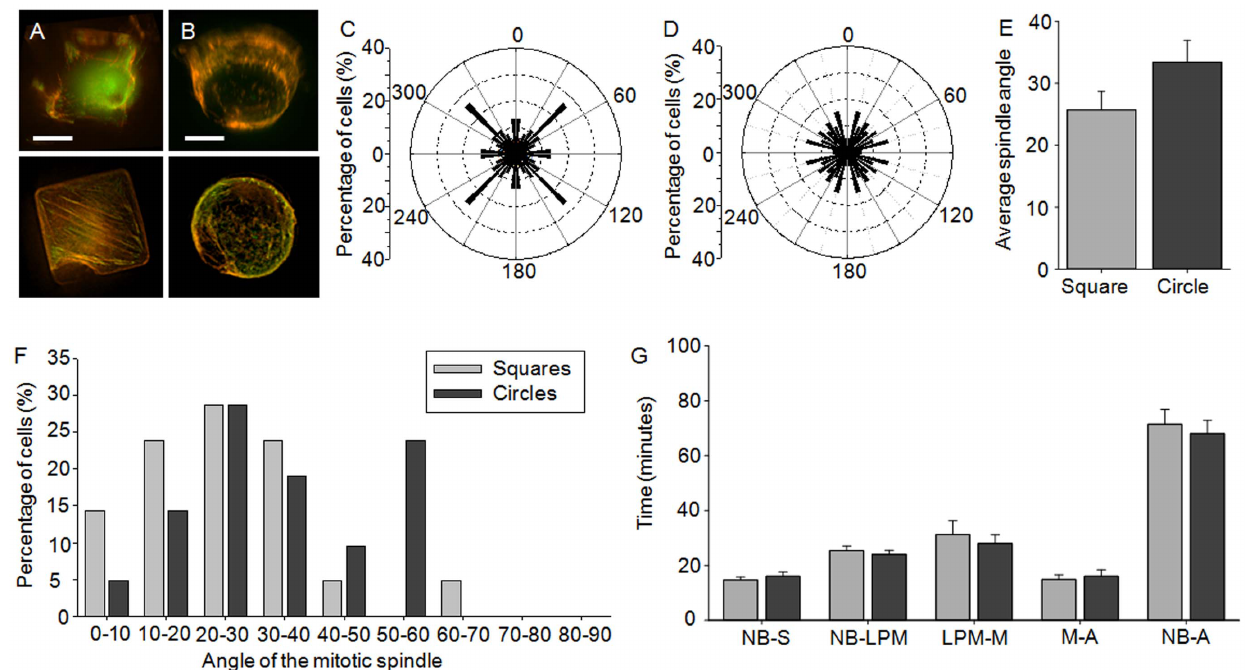
Figure 5. The role of the actin cytoskeleton in the shape dependent differences in mitosis. HeLa (YFP-paxillin) cells were cultured for 18 hours in either (A) square microwells or (B) circular microwells and imaged during interphase for actin (red) and paxillin (green); bars: 10 m m. HeLa (GFP-H2B/RFP-tubulin) cells were assessed for the parallel orientation of the mitotic spindle at metaphase after culture in (C) square or (D) circular microwells and treatment with latrunculin A for 1 hour prior to mitosis. Cells cultured in circular microwells showed a random orientation of the mitotic spindle, whilst cells cultured in square microwells predominately aligned the spindle along the long axis of the cell. (E) The inhibition of actin polymerization in HeLa (GFP-H2B/RFP-tubulin) cells lead to increased tilting in cells cultured in the square microwells. Values represent spindle angle in degrees 6 SEM. (F) Perturbation of actin polymerization in cells cultured in square microwells also increased the distribution of spindle orientation, but had little effect on cells cultured in circular microwells. (G) The perturbation of the actin cytoskeleton negated the differences in mitotic timings observed between cells cultured in square microwells (light grey bars) and cells cultured in circular microwells (dark grey bars). All values represent time in minutes 6 SEM. NB = nuclear envelope breakdown, S= spindle formation, LPM = late prometaphase, M= metaphase, A=